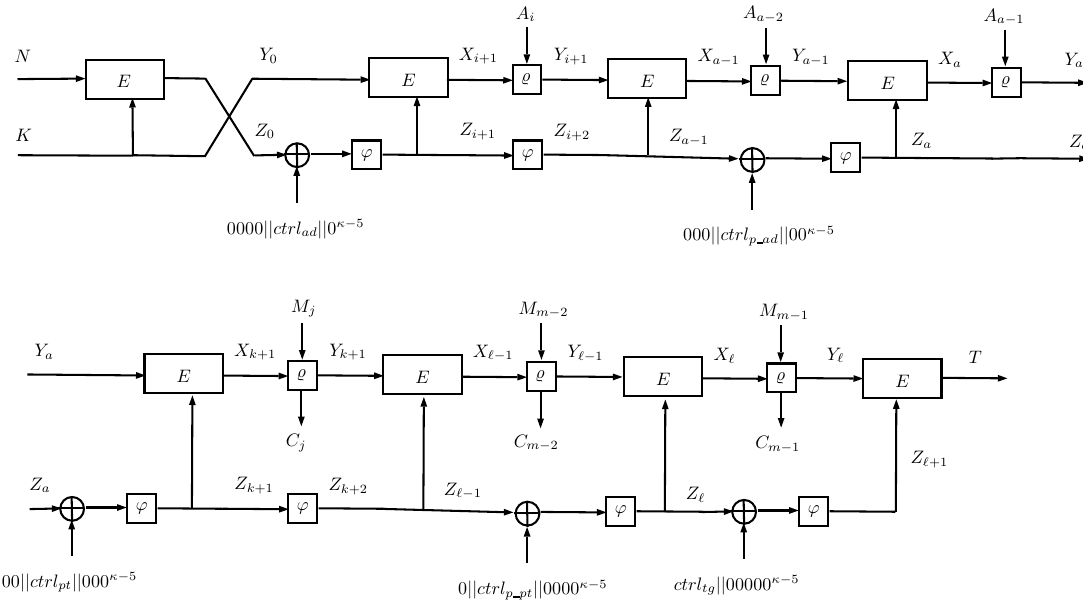
Figure 9. Block diagram for